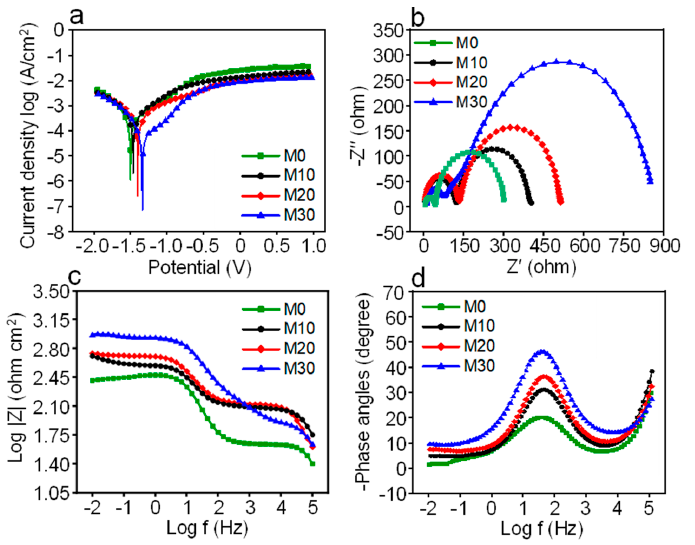
Figure 6. ( a ) Potentiodynamic polarization curves. ( b ) Nyquist diagrams. ( c ) Bode impedance plots. ( d ) Bode phase angle curves. Table 2. Tafel fitting results derived from the polarization curves of laser-sintered specimens.